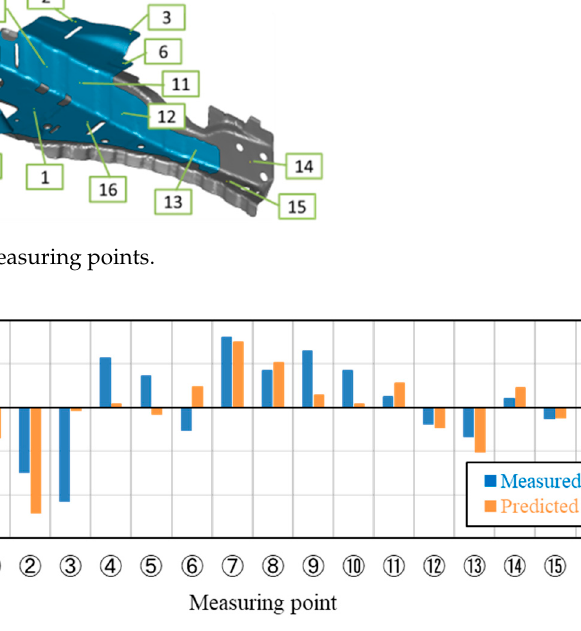
Figure 17. Distortion of the nugget model.